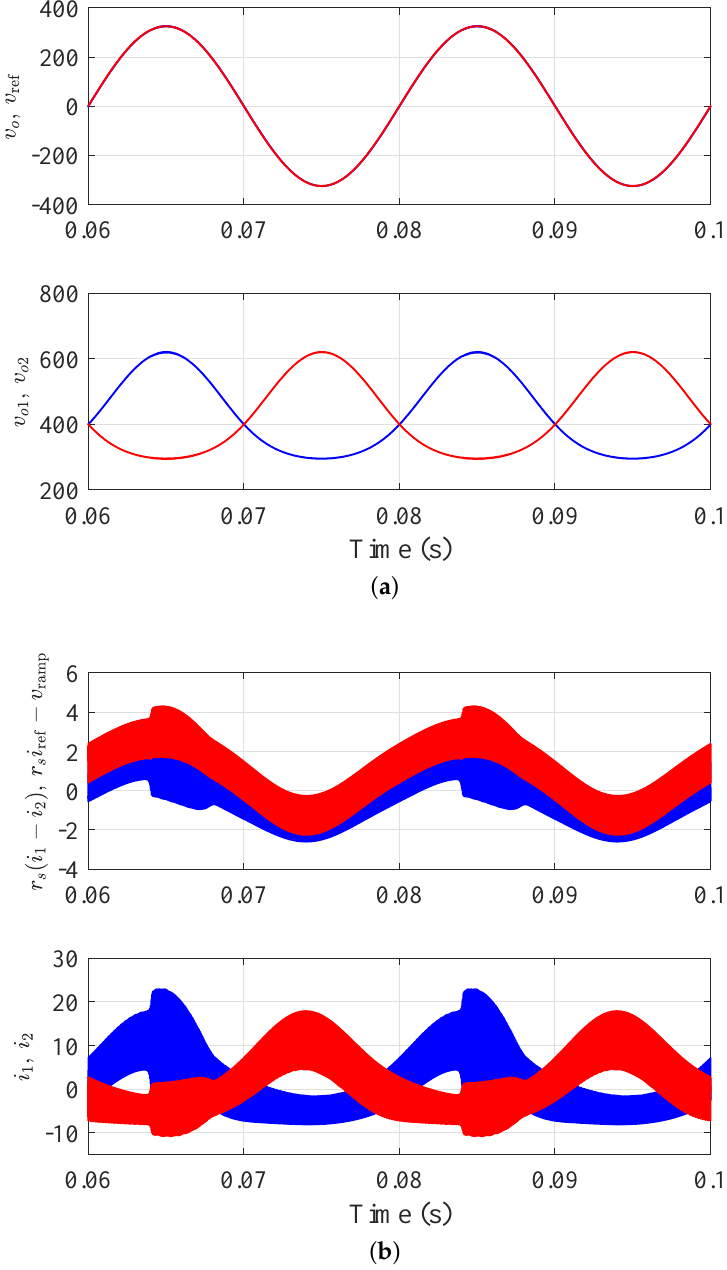
Figure 3. Steady-state response of boost inverter with k p = 0.4 and V M = 2 V. ( a ) Capacitor voltages v o 1 and v o 2 , output and reference voltages v o and v ref . ( b ) Inductor currents i 1 and i 2 and control signals r s ( i 1 i 2 ) and r s i ref v ramp . For each subplot, traces correspond to the shown voltages in [V] and currents − − in